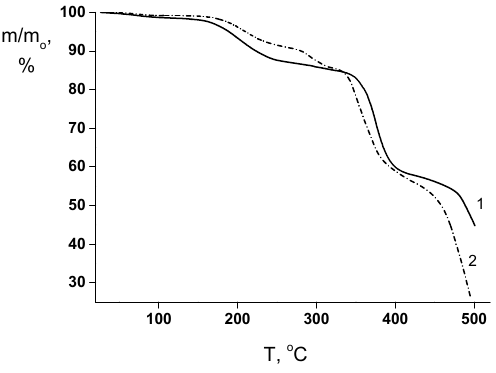
Figure 6. TGA curves of (1) PEA and (2) PEA–Cu(I) membranes.